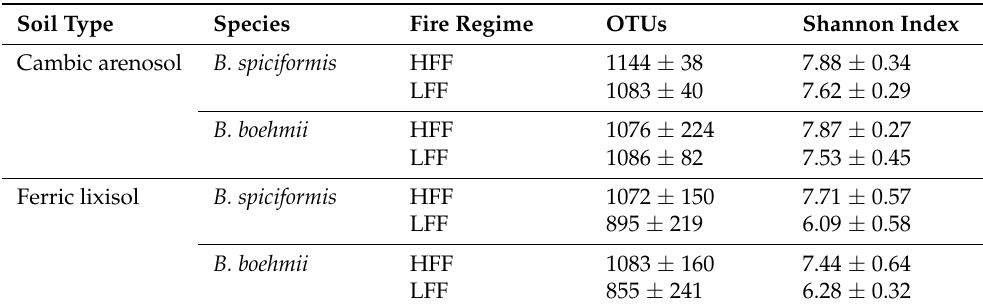
Table 2. Mean and standard deviation number of operational taxonomic units (OTUs) and Shannon index values found in the rhizosphere of Brachystegia spiciformis and Brachystegia boehmii sampled in cambic arenosol and ferric lixisol soils under low (LFF) and high fire frequencies (HFF). Each value represents the mean ± standard deviation ( n = 3).